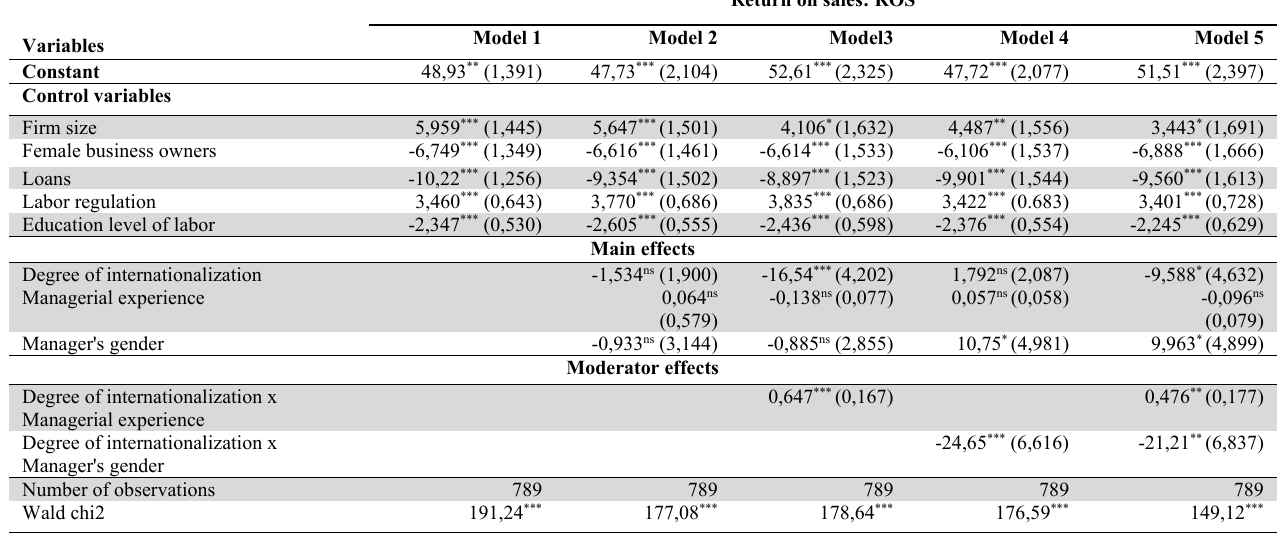
Feasible Generalized Least Squares